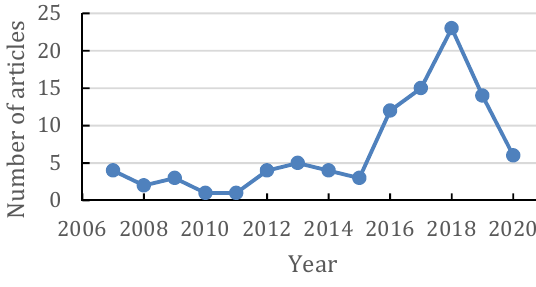
Figure 1. Graphic of total articles used by year.